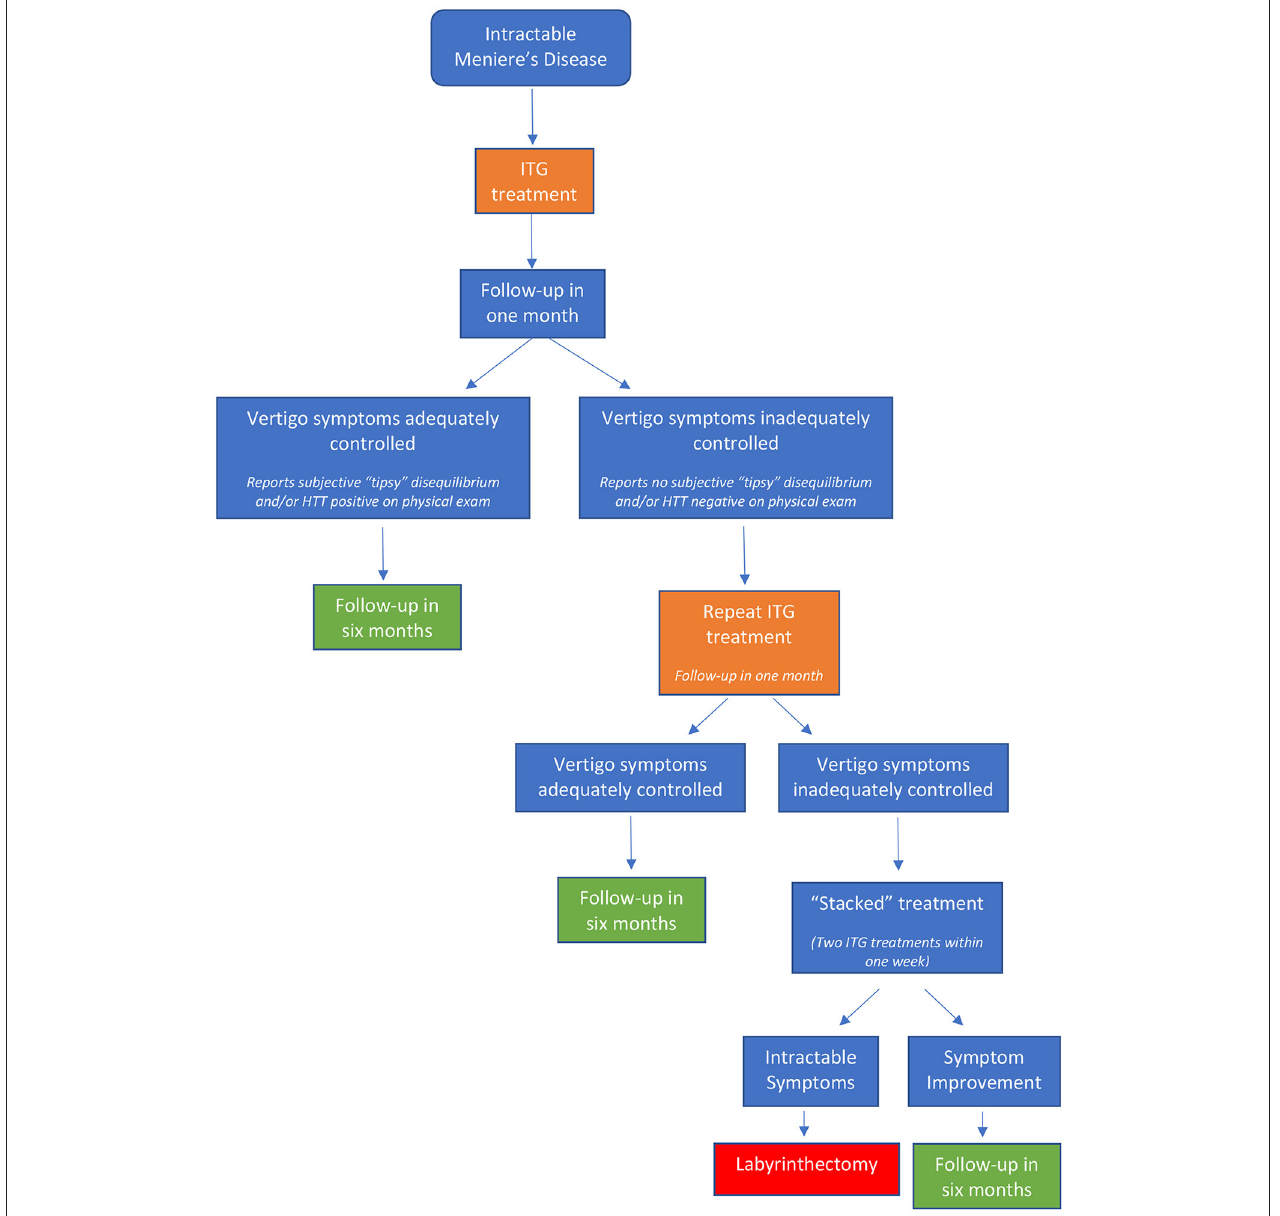
FIGURE 1 | ITG flow